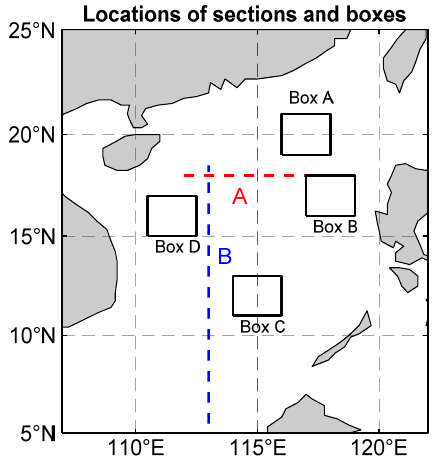
Figure 6. The zonal section A (latitude of 18 ◦ N), and meridional section B (longitude of 113 ◦ E) are defined to analyze the vertical variation of OSTS. Boxes a–d represent four boxes used in this study, Box A (116~118 ◦ E, 19~21 ◦ N), Box B (117~119 ◦ E, 16~18 ◦ N), Box C (114~116 ◦ E, 11~13 ◦ N), and Box D (110.5~112.5 ◦ E, 15~17 ◦